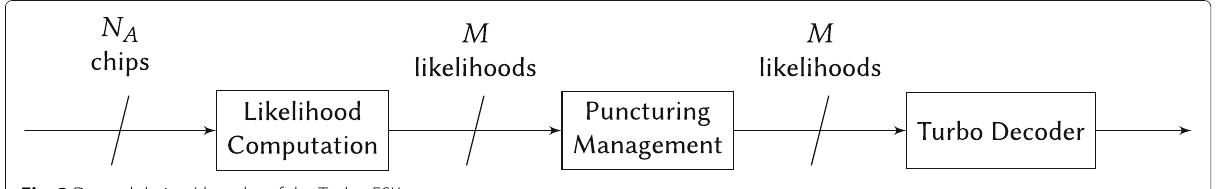
Fig. 3 Demodulation/decoder of the Turbo-FSK